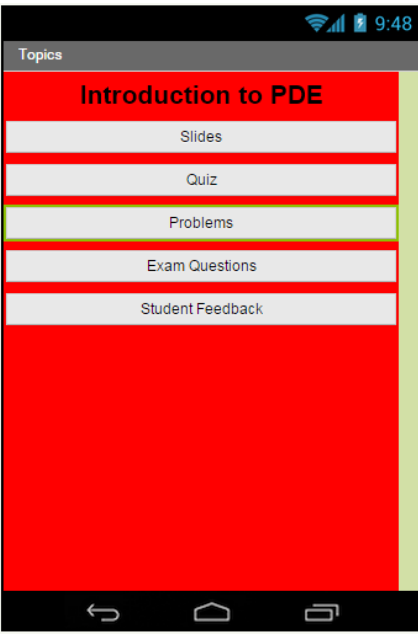
Fig. 4. Topics screen of the application after we select the first option